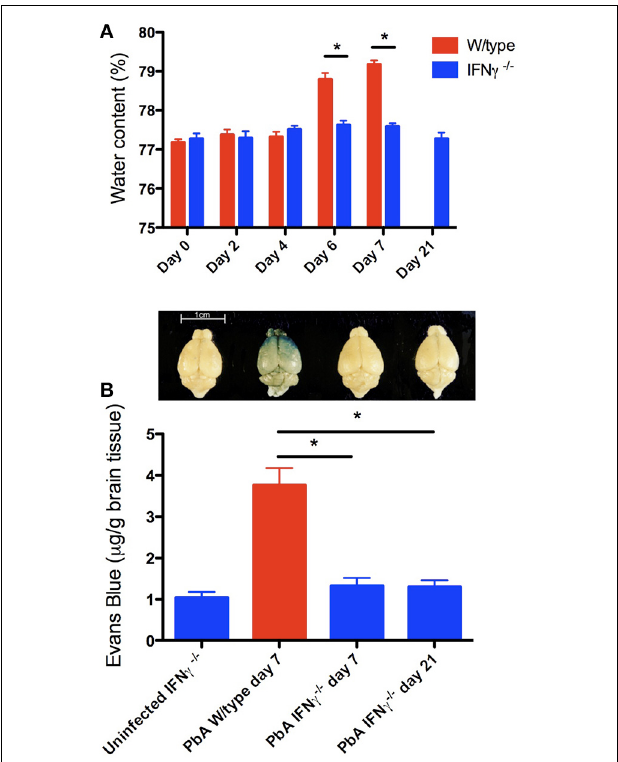
FIGURE 2 | Brain edema and blood-brain barrier compromise after PbA infection. Water content was calculated from wet and dry weight. Evans blue, a dye that binds to circulating albumin, was injected intravenously 2h before mice were euthanased; the brain was perfused with saline, removed, photographed, and water-extracted; the Evans blue content was measured spectrophotometrically at 510nm. (A) PbA-infected wild-type mouse brains had significantly greater water content compared with infected IFN- γ − / − mice at days 6 and 7 post-inoculation ( ∗ p < 0 . 001, Two-Way ANOVA with Bonferroni post-test). (B) PbA-infected wild-type mice had significantly greater extravasation of Evans Blue dye into the brain parenchyma on day 7 post-inoculation compared to infected IFN- γ − / − mice on day 7 or 21 post-inoculation ( ∗ p < 0 . 001, One-Way ANOVA with Bonferroni post-test). Above each bar of the graph is shown a representative brain from that experimental group. Columns and vertical bars are mean ± s.e.m. ( n = 5 per